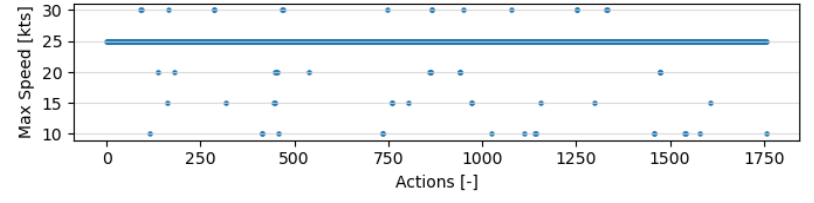
Figure 14. All maximum speeds set in one training episode.